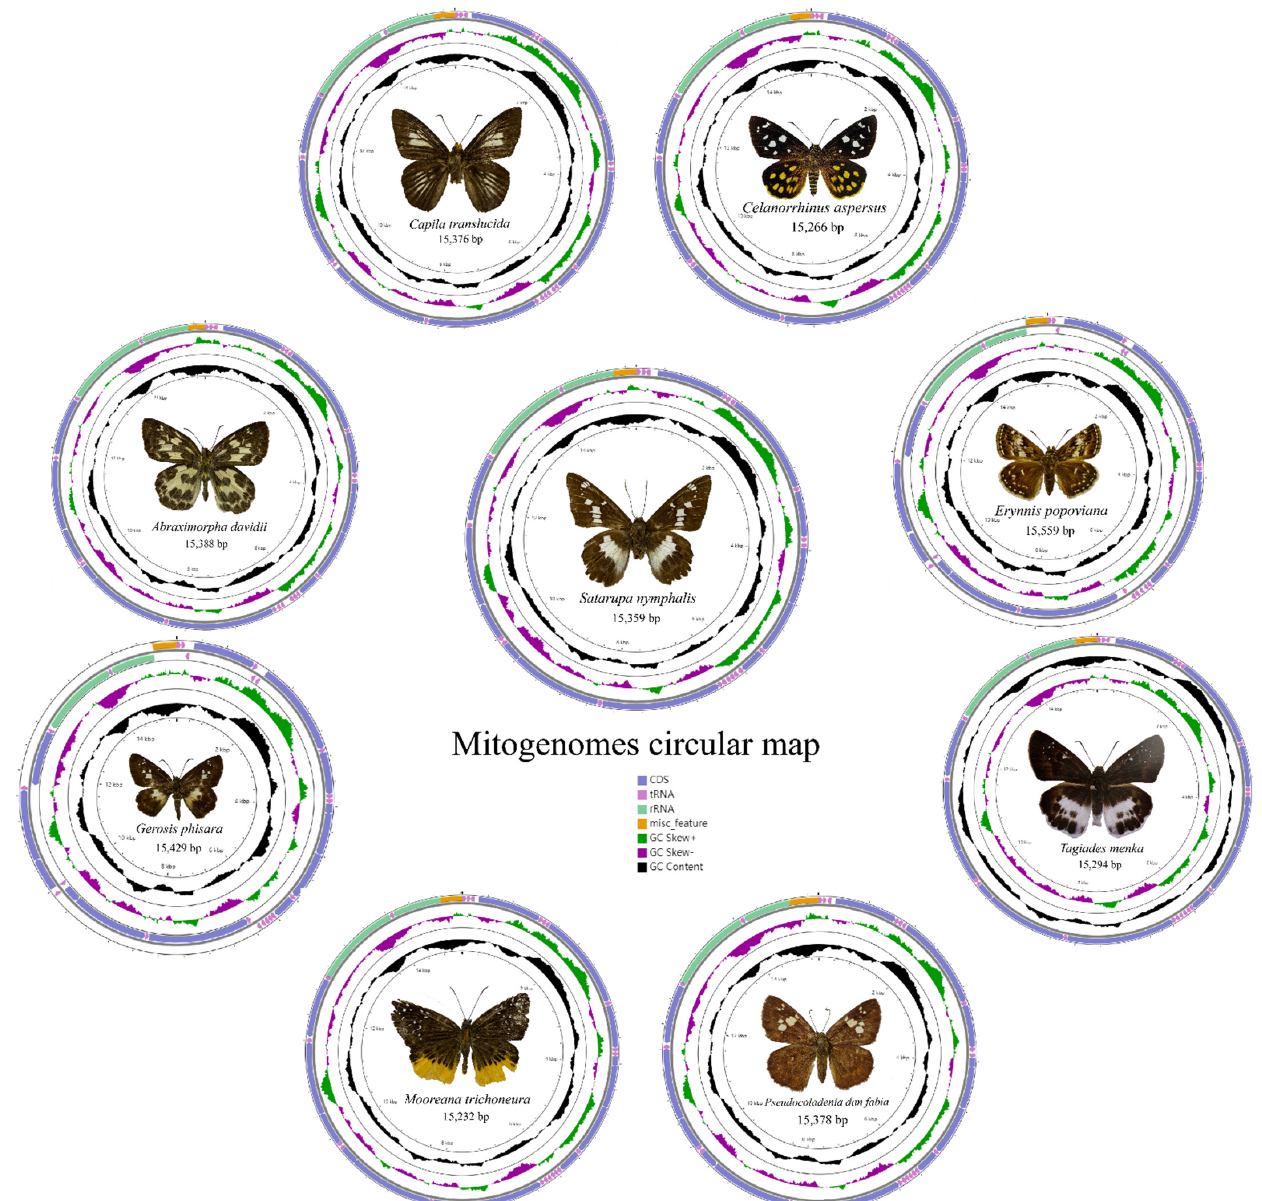
Figure 1. Circular maps of the mitogenomes of nine species. All the nine mitogenomes contain 13 protein coding genes (PCGs), 22 transfer RNA genes (tRNAs), 2 ribosomal RNA genes (rRNAs), and an AT-rich region. Like many other insect mitogenomes, its major strand codes for 23 genes (9 PCGs and 14 tRNAs), while the minor strand codes for the remaining 14 genes (4 PCGs, 8 tRNAs, and 2 rRNA genes). The orientation and gene order of these mitogenomes of nine species are identical to the hypothesized ancestral arthropod arrangement found in the insect Drosophila yakuba [51]. The nucleotide composition of the nine mitogenomes is significantly biased towards A and T, with a relative A + T content of 79.5% to 82.4% in the whole genome, 77.5% to 80.9% in the PCGs, 81.2% to 83% in the transfer RNAs, and 84.3% to 86% in the ribosomal RNAs. Nearly all AT-skew and GC-skew are negative, except for the AT-skew in Ce. aspersus (0.003) and Sat. nymphalis (0.026), showing that there are more TC than AG across the whole mitogenome (Table